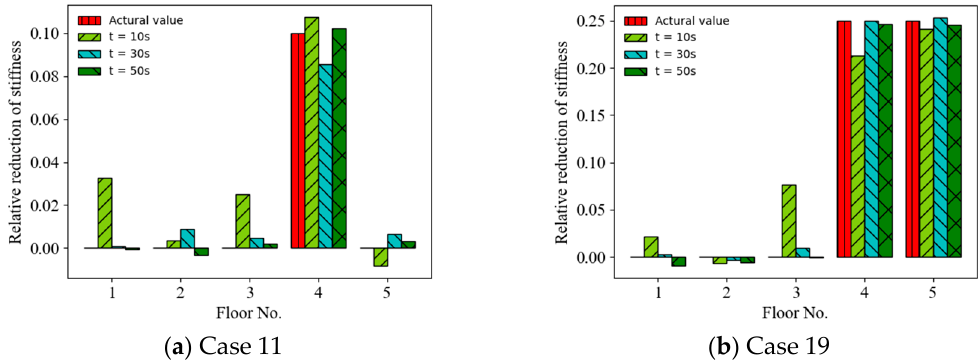
Figure 9. Mean prediction results of structural anomaly using displacement responses with different time lengths as ANN input.